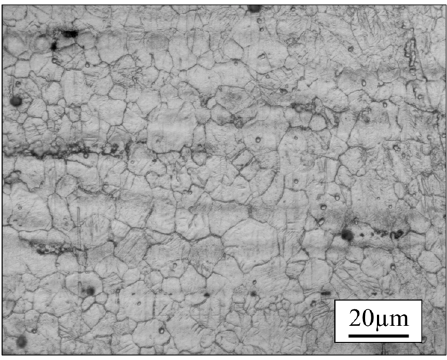
Figure 2. Initial microstructure of the as-extruded AM50 Mg alloy.